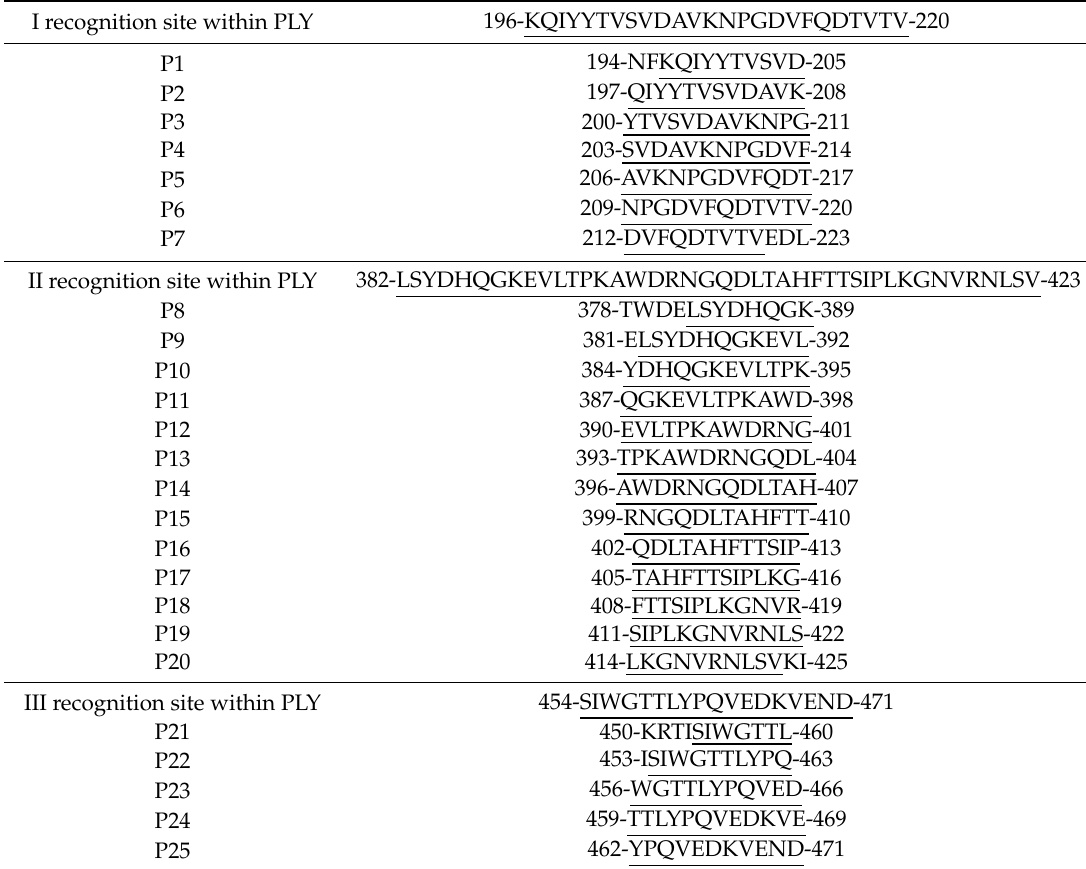
Table 3. Synthetic peptides used for epitope